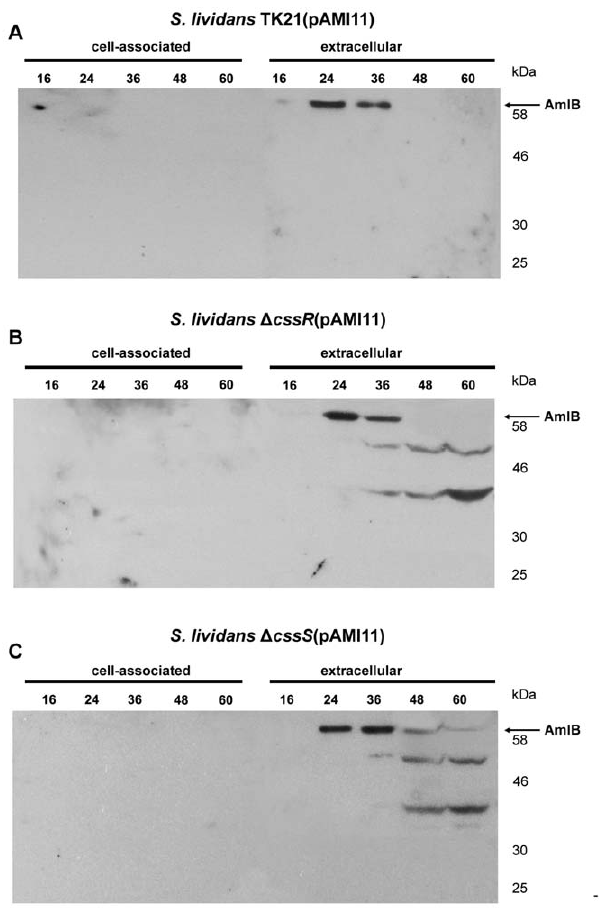
Figure 2. Alpha-amylase secretion pattern of S.lividans TK21 and the CssS and CssR deficient strains. Cell-associated and extracellular amylase present in S. lividans TK21 (pAMI11) (A), S. lividans D cssR (pAMI11) (B) and S. lividans D cssS (pAMI11) (C) at different times of growth were analyzed by Western blotting with antibodies raised against AmlB. The amount of protein loaded onto the gels was corrected by the dried weight of the bacterial cultures. Molecular size markers are indicated on the side of each panel. An arrow indicates the relative mobility of the mature AmlB.